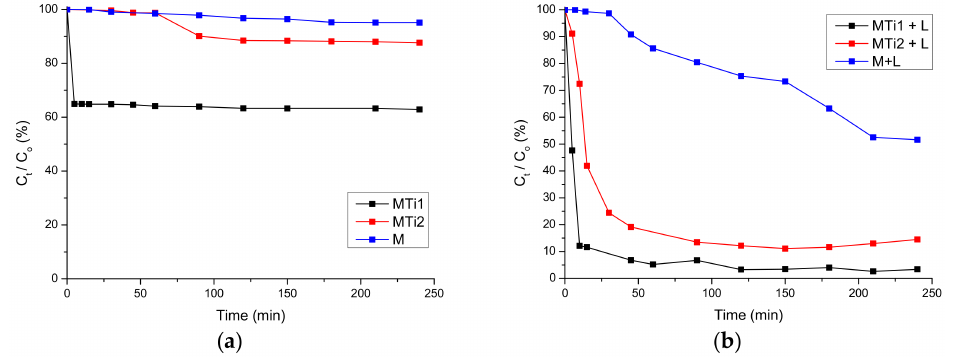
Figure 7. ( a ) Degradation of TCB in darkness and ( b ) under ultraviolet